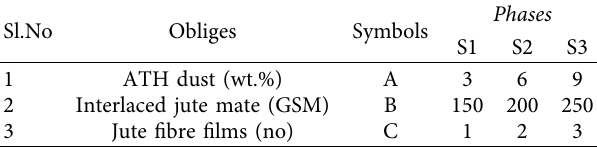
Table 1: Obliges and their legs for hybrid compound.